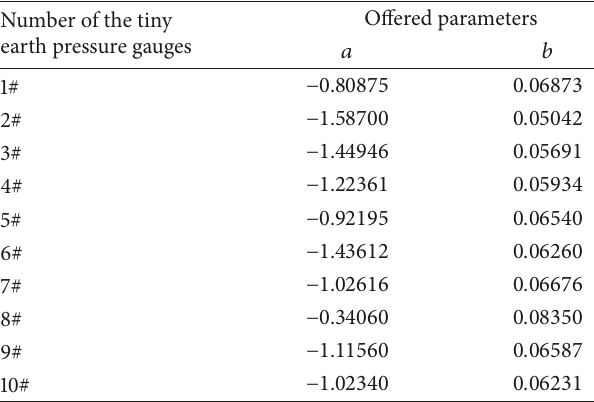
Table 2: Offered parameters of the 0.1 MPa tiny earth pressure gauges.